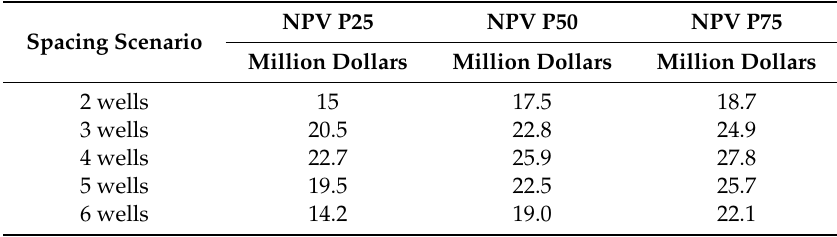
Figure 10. Economic uncertainty distribution with the five different well spacing scenarios. Table 5. Summary of the P25, P50, P75 values of the NPV distributions for all five different spacing scenarios.